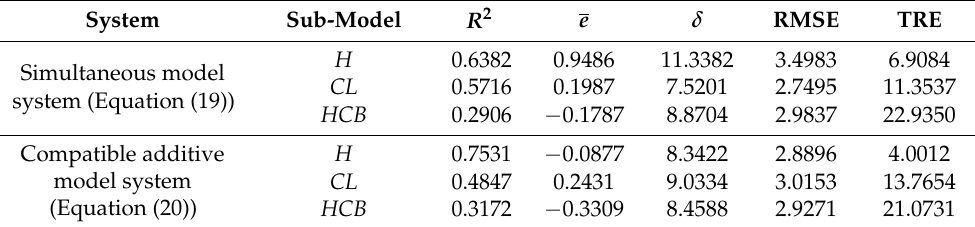
Table 7. Evaluation indices of Equations (19) and (20) based on the validation data ( H : total tree height; CL : crown length; HCB : height to live crown base; R 2 : coefficient of determination; e : bias; δ : bias variance; RMSE: root mean square error; TRE: total relative error).